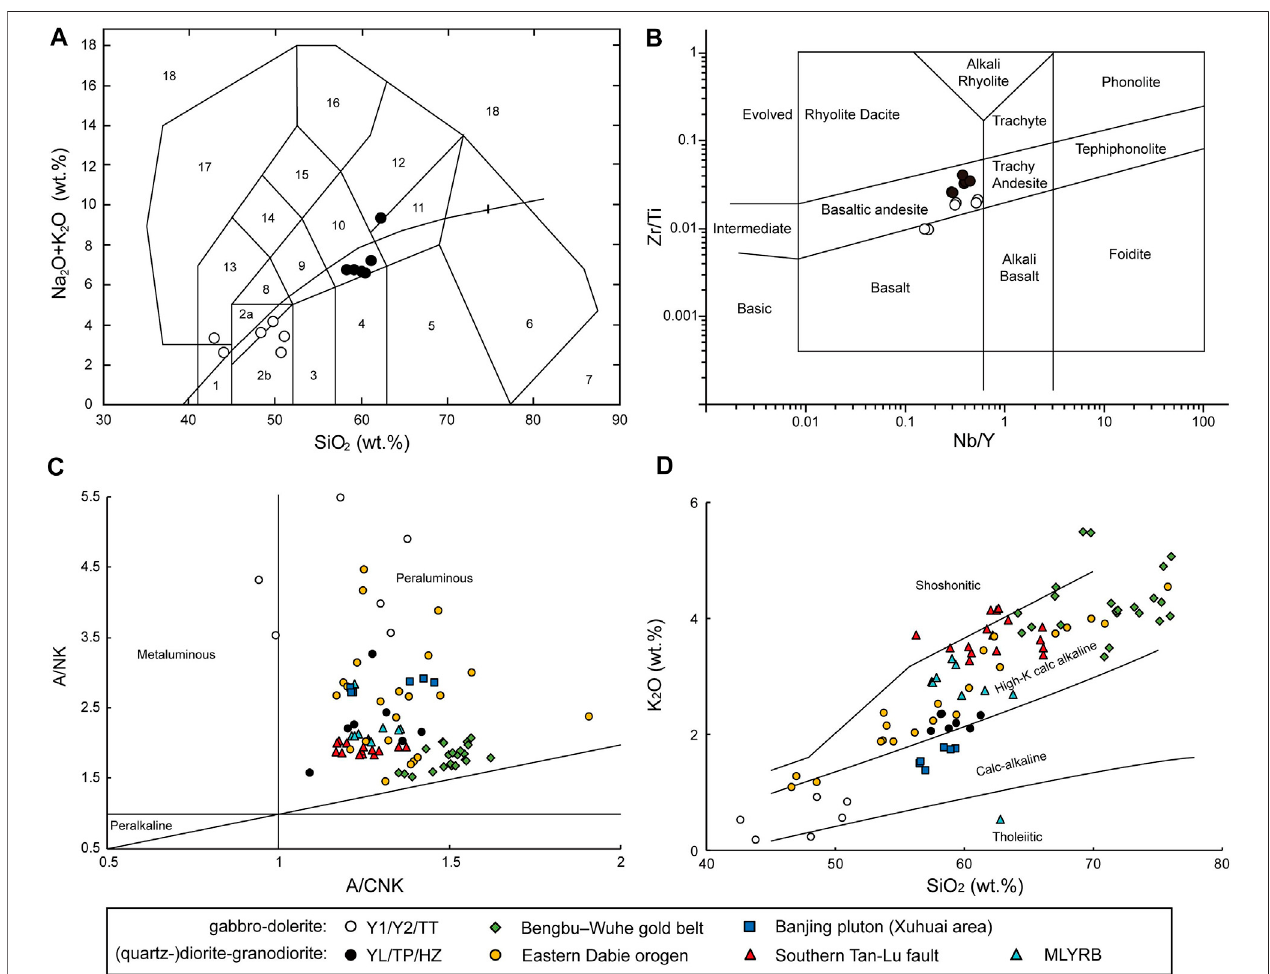
FIGURE 7 | Petrological classi fi cation plots for the igneous rock samples from the Huaibei-Linhuan coal fi eld: (A) Total Alkali Silica (TAS) (base map after Middlemost, 1994). The curve denotes the Ir (Irvine) boundary, separating the alkaline (above) and sub-alkaline (below). Number: 1) olivine gabbro; 2a) alkaline gabbro; 2b) sub-alkaline gabbro; 3) gabbroic diorite; 4) diorite; 5) granodiorite; 6) granite; 7) quartzolite; 8) monzogabbro; 9) monzodiorite; 10) monzonite; 11) quartz monzonite; 12) syenite; 13) foid gabbro; 14) foid monzogabbro; 15) foid monzosyenite; 16) foid syenite; 17) foidolite; 18) tawite/urtite/italite; (B) Zr/Ti vs. Nb/Y (after Pearce, 1996); (C) A/NKvs.A/CNK(basemapafterManiarandPiccoli,1989); (D) K 2 Ovs.SiO 2 (afterPeccerilloandTaylor,1976).For Figures5 – 6 , 9 – 10 ,datafromtheadakitic rocks intheBengbu-Wuhegoldbelt(LiC.etal.,2020),Banjingpluton (Zhouetal.,2019),EasternDabieOrogen(Zhangetal.,2013),Lower YangtzeRiverBelt(LiuS.-A. et al., 2010) and southern Tanlu fault (Liu S.-A. et al., 2010) are also shown for comparison.